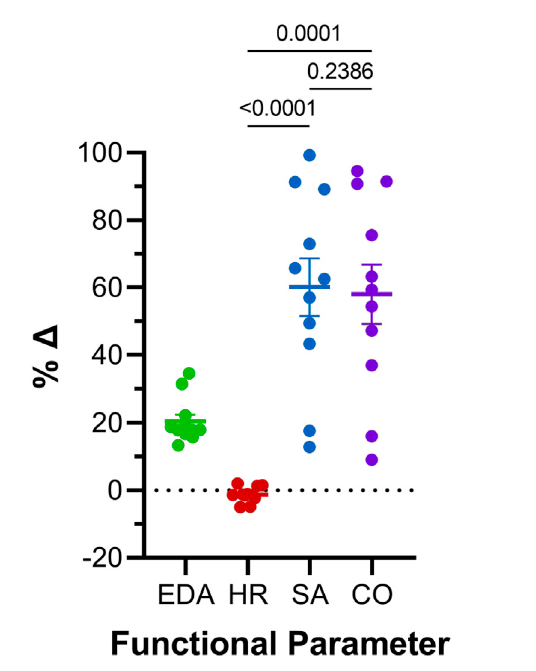
FIGURE 6 Comparison of effects of atrial preload application on functional parametersin48hpfzebra fi shlarvae.Percentagechange(% Δ )ofend- diastolic area (EDA), heart rate (HR), stroke area (SA), and area cardiac output (CO A ) averaged over all periods of load application. Average values presented as mean ± SEM. Means for each measured parameter were compared by one-way ANOVA, with Tukey post hoc tests for pairwise comparisons. n = 11